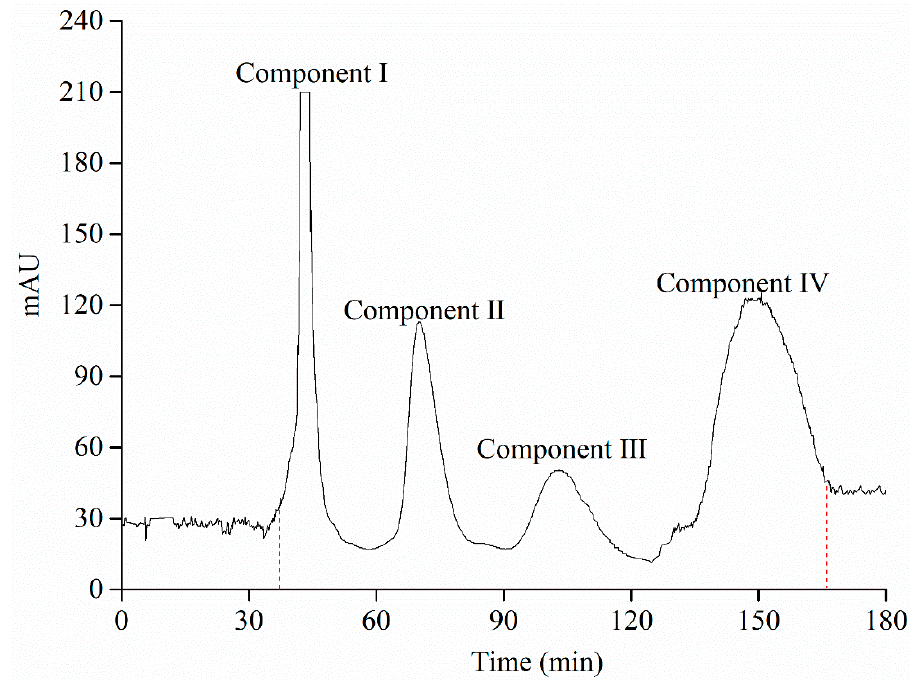
Figure 5. High-speed counter current chromatography (HSCCC) chromatogram of the purified anthocyanin extract samples.